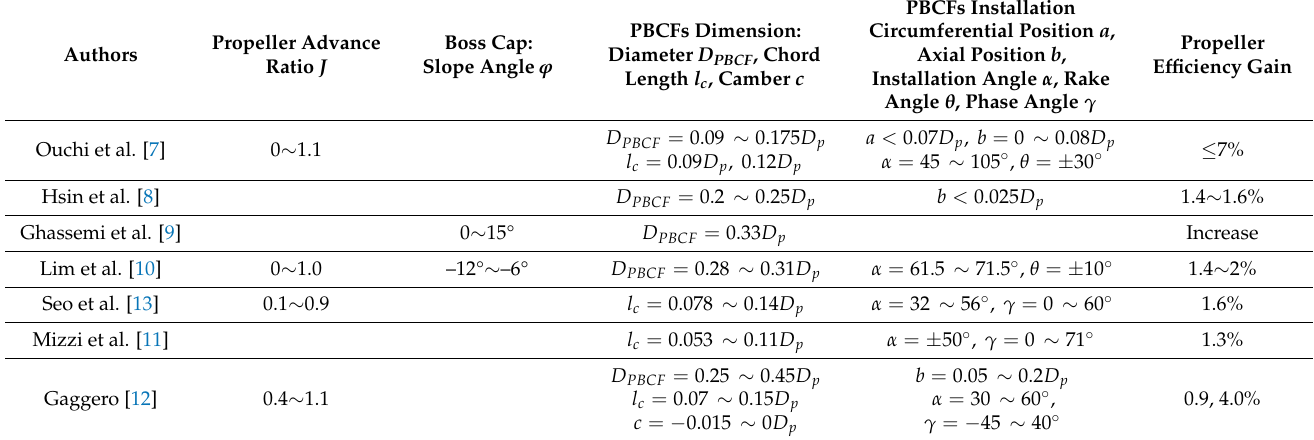
Table 1. The PBCF dimensions and installation—the parameters and ranges chosen by different researchers.